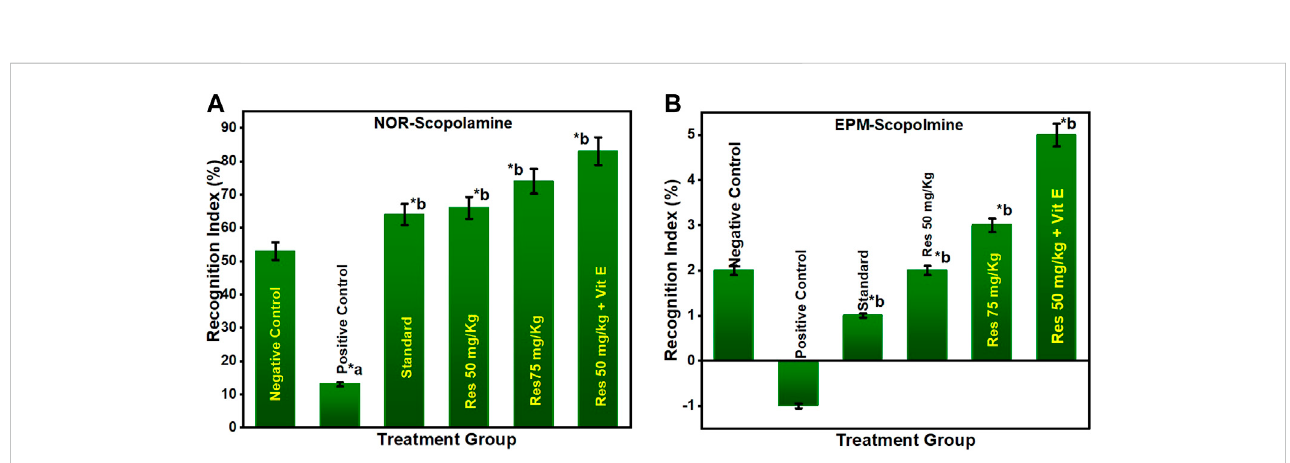
FIGURE 3 BehaviouralanalysisforNORandEPM; (A) recognitionindicesinNORforthescopolaminemodel; (B) in fl ectionratiosinEPMforthescopolaminemodel. a negative control vs. positive control; b positive control vs. treatment